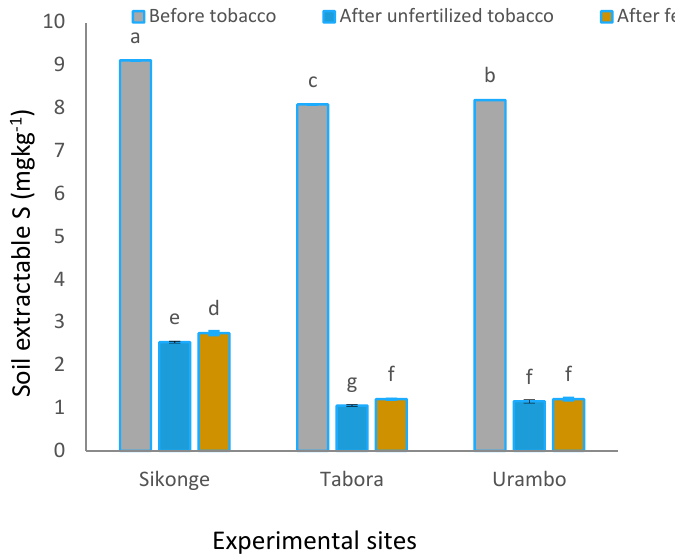
Figure 5. Effect of tobacco and fertilization on soil S. ‘a’ is very highly significant; ‘b’ is highly significant; ‘c’, ‘d’ & ‘e’ are significant; ‘f’ & ‘g’ non